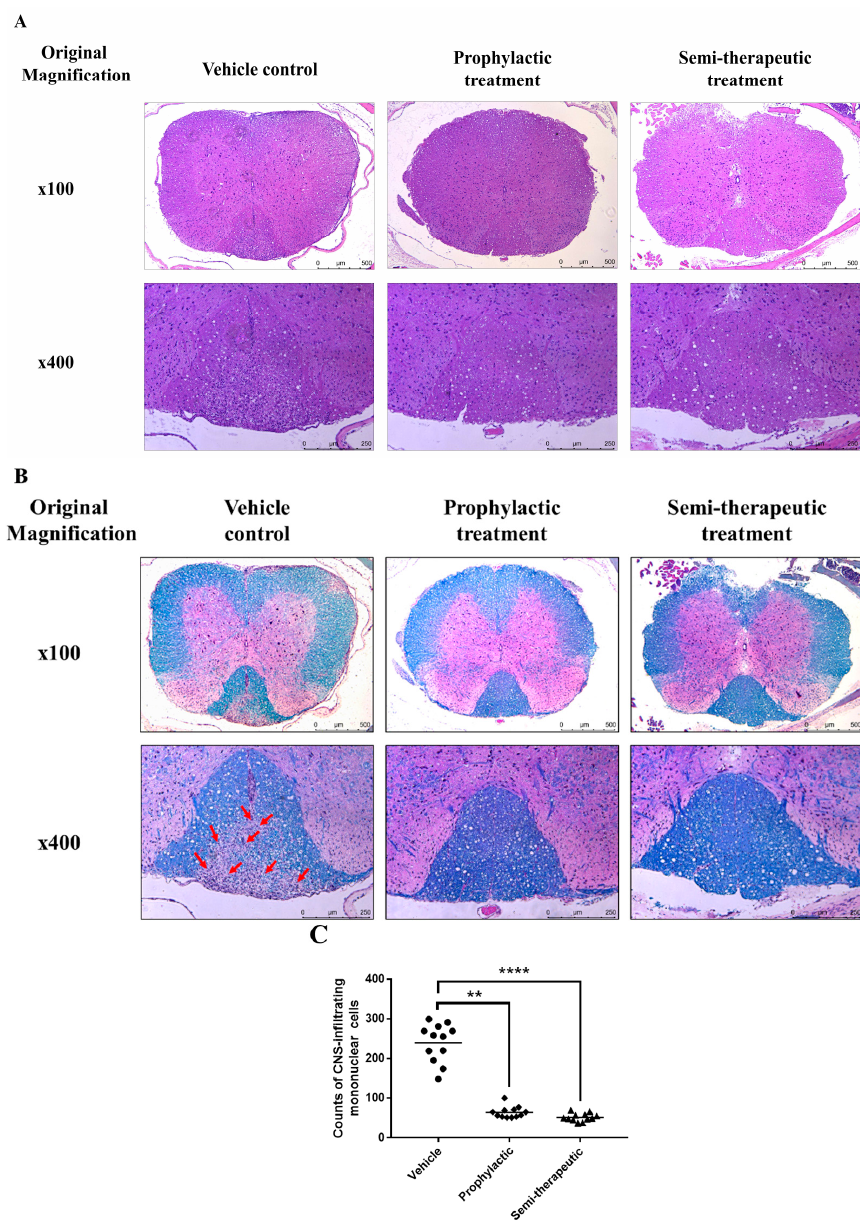
Figure 2. GLP-1 RA dulaglutide treatment obviously alleviates the lymphocyte infiltration, vacuolar degeneration, and neuronal demyelination in the CNS of MOG-immunized mice. ( A ) Analysis of hematoxylin and eosin (H&E) stain of the spinal cord tissue section. ( B ) Analysis of Luxol Fast Blue (LFB) stain of the spinal cord tissue section. Spinal cords were removed from mice at day 14 after MOG 35 – 55 immunization. Spinal cords were analyzed with hematoxylin and eosin stain. Demyelinated areas were indicated as red arrows. ( A and B ) Representative results of prophylactic, semi-therapeutic dulaglutide treatment and vehicle control were showed. Upper row was showed as magnification x100 and the lower row was showed as x400. Each group had three mice for H&E stain and LFB stain, respectively. ( C ) Cell counts of central nervous system (CNS)-infiltrating mononuclear cells from the dorsal white matter of spinal cord in EAE mice received vehicle (filled circle), prophylactic (filled diamond), or semi-therapeutic (filled triangle) treatment of dulaglutide. Four non-redundant regions with 400x high power magnification were acquired from individual mouse and then further calculated by Image J software. All data are representative of three mice in each group and presented as mean. ** p < 0.01 and **** p < 0.0001 by the non-parametric Kruskal–Wallis test followed by post-hoc test, Dunn`s multiple comparisons test.